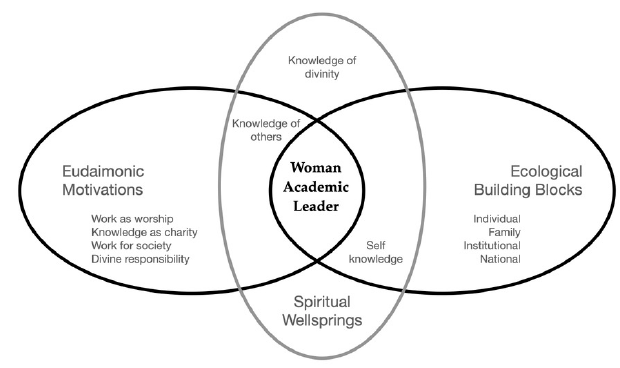
Figure 2. Summary of